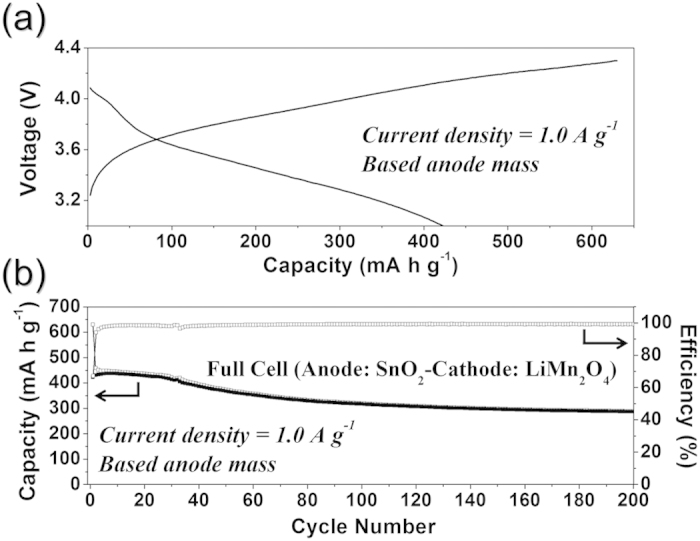
Electrochemical properties of a full cell of anode (hollow SnO2 nanospheres)/cathode (LiMn2O4): (a) charge–discharge curves at a current density of 1.0 A g−1 and (b) cycling performance at a current density at 1.0 A g−1 based on the anode (hollow SnO2 nanospheres) mass.